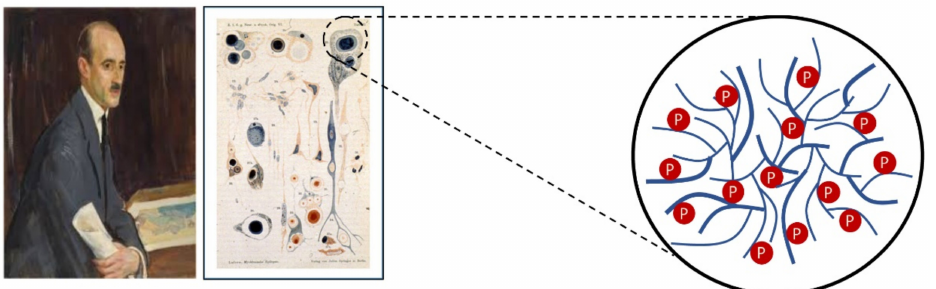
Figure 2. In 1911, the Spanish neurologist Dr. Gonzalo Rodriguez Lafora described polyglucosan bodies in the perikaryon of neurons in the cerebral cortex, thalamus, globus pallidus, and substantia nigra of affected patients. Lafora bodies are the result of the aggregation of long, unbranched, hyperphosphorylated and insoluble forms of glycogen. The left panel shows a painting of Dr. Lafora displayed at Prado Museum (Madrid). The middle panel shows a copy of the original paintings of neurons from affected patients. The right panel shows a cartoon of the hyperphosphorylated aberrant glycogen present in Lafora